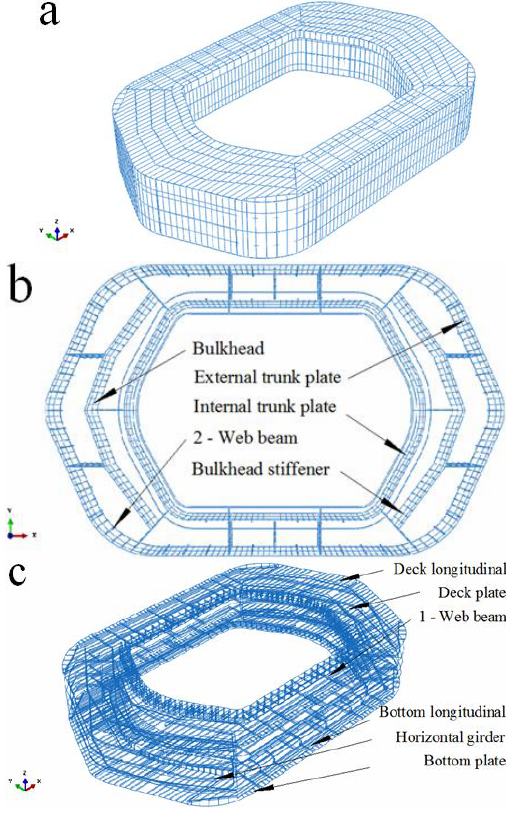
Figure 1. Sketch of protective device ( a ) isometric view, ( b ) top view and ( c ) perspective view with a code of each cabin.